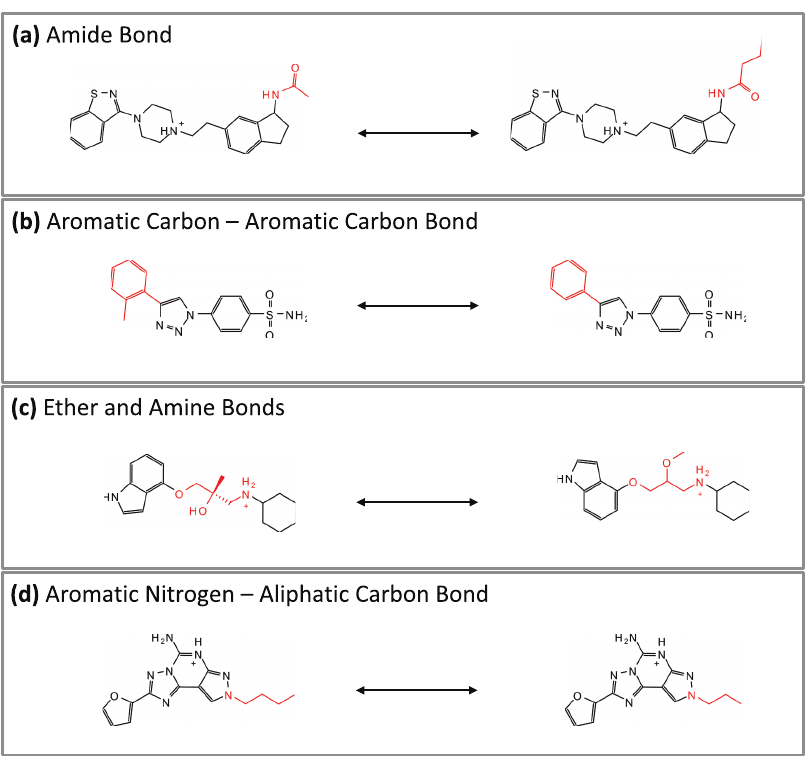
Figure 3. RECAP-MMPs. In ( a )–( d ), four exemplary RECAP-MMPs representing different retrosynthetic rules are shown. For each RECAP- MMP, the chemical transformation is highlighted in red.